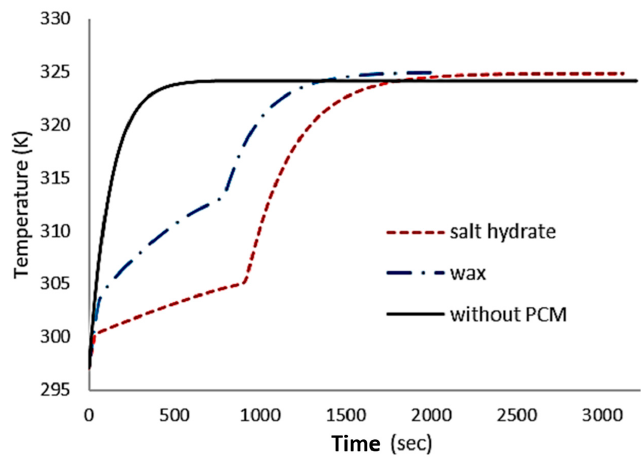
Figure 8. Temperature profile of the heat sink with and without PCM under a heat flux of 1250 W/m 2 .